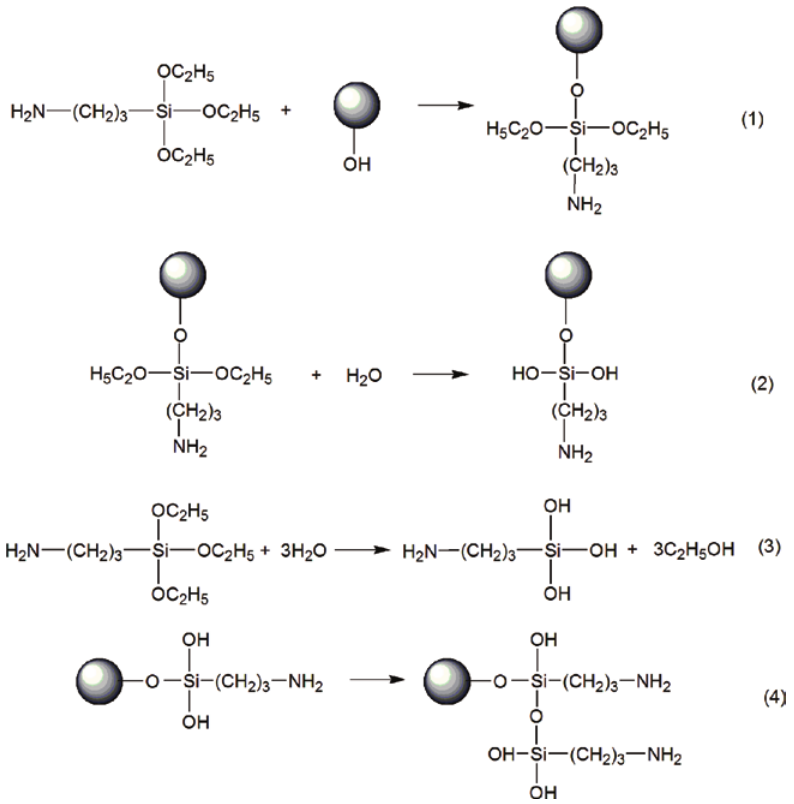
Figure 3: The modification mechanism of diamond with KH550 in toluene